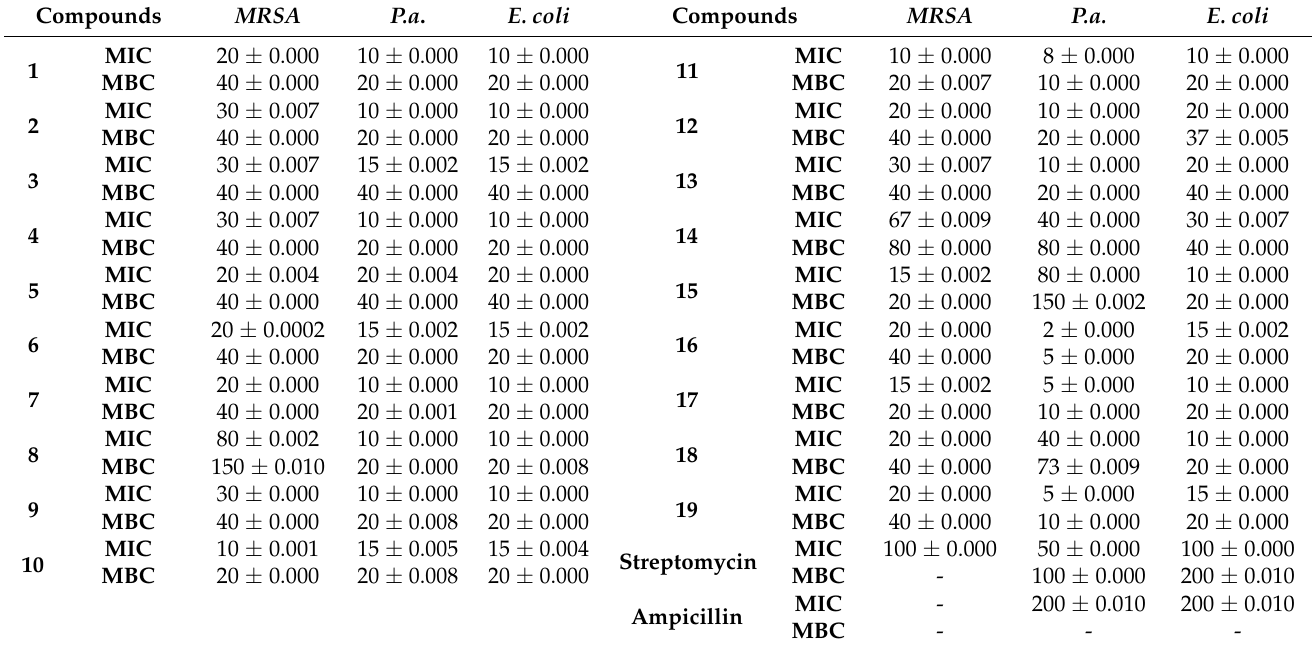
Table 3. Antibacterial activity of compounds 1 – 19 against resistant strains (MIC and MBC in µ